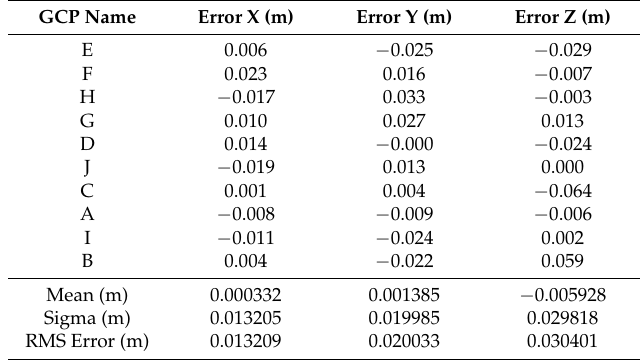
Table A1. Coregistration error of orthoimage and DSM estimated at ground control